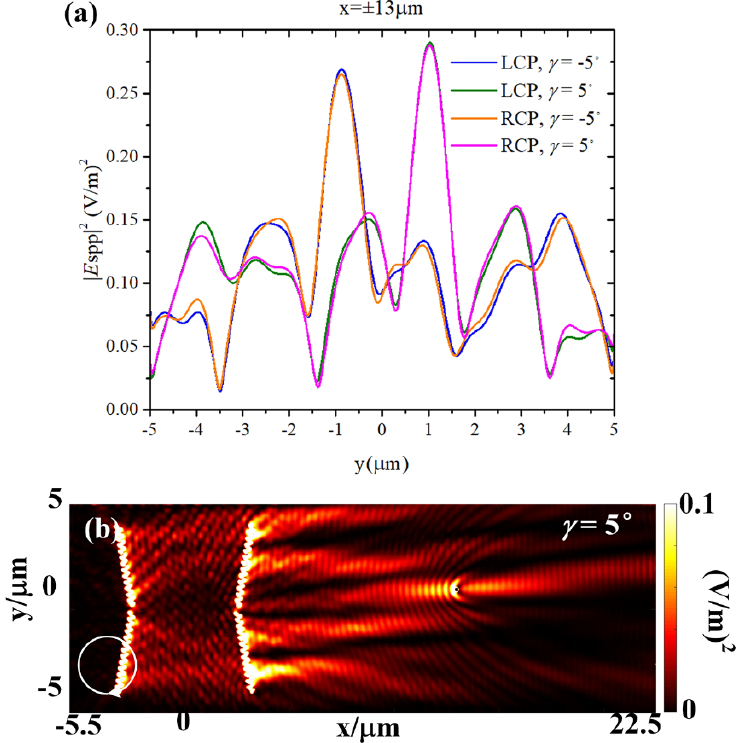
Figure 5. ( a ): The transversal electric field intensity distributions at x = ± 13 µ m. The blue and orange lines correspond to the conditions in which the inclined angle is − 5 ◦ under different polarization states; the green and purple lines correspond to the conditions in which the inclined angle is 5 ◦ under different polarization states. ( b ) The intensity distribution of the nondiffracting SPP beam in the case in which a cylinder obstacle exists.